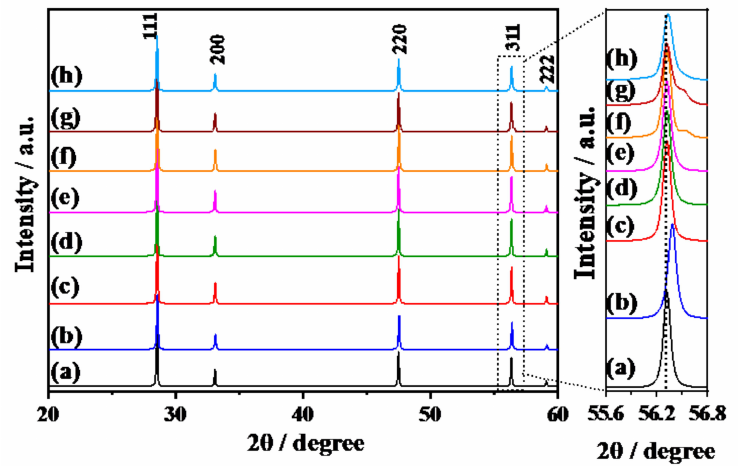
Figure 1. X-ray diffraction patterns of 1573K-Pure-CeO 2 ( a ), 1573K-CPT ( b ), 1273K-SSR ( c ), 1373K- SSR ( d ), 1473K-SSR ( e ), 1573K-SSR ( f ), 1673K-SSR ( g ), and 1773K-SSR ( h